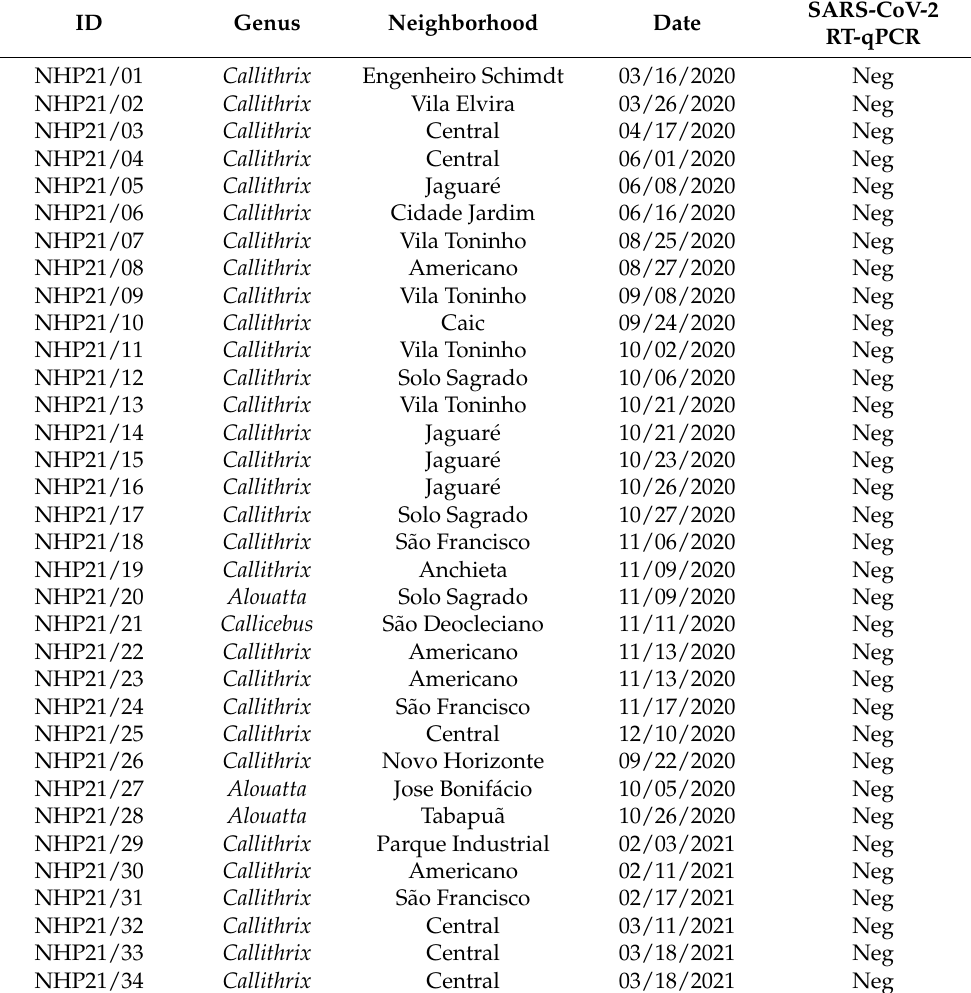
Table 1. Characteristics of neotropical non-human primates investigated in S ã o Jos é do Rio Preto.